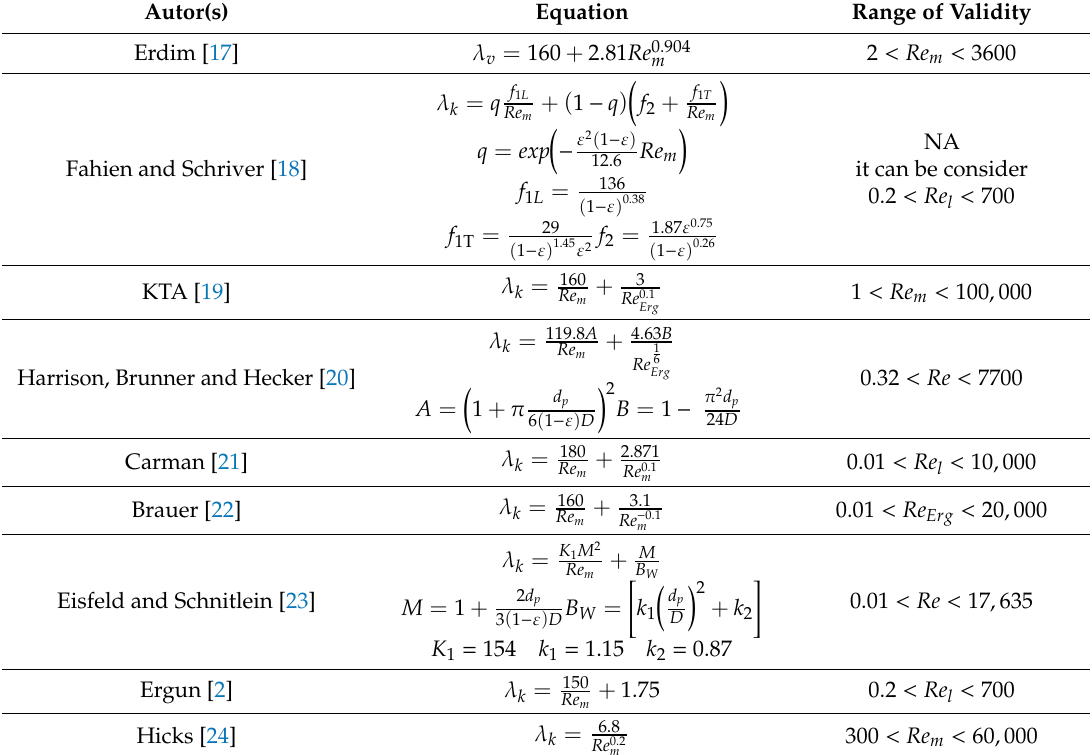
Table 3. Suitable equations for calculating of friction coe ffi cient for the packed bed of